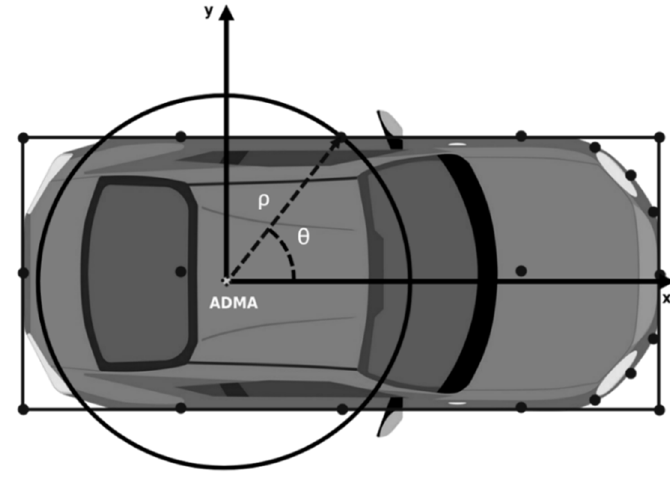
Figure 11. Vehicle schematization polar coordinates.